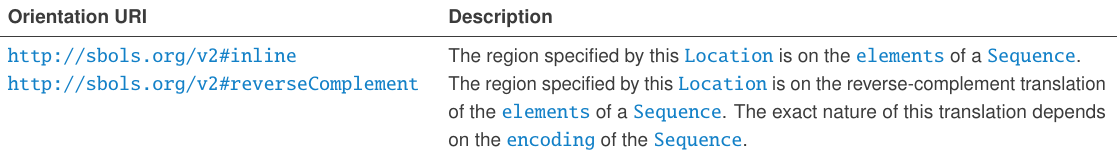
Table 8: REQUIRED URI s for the orientation property